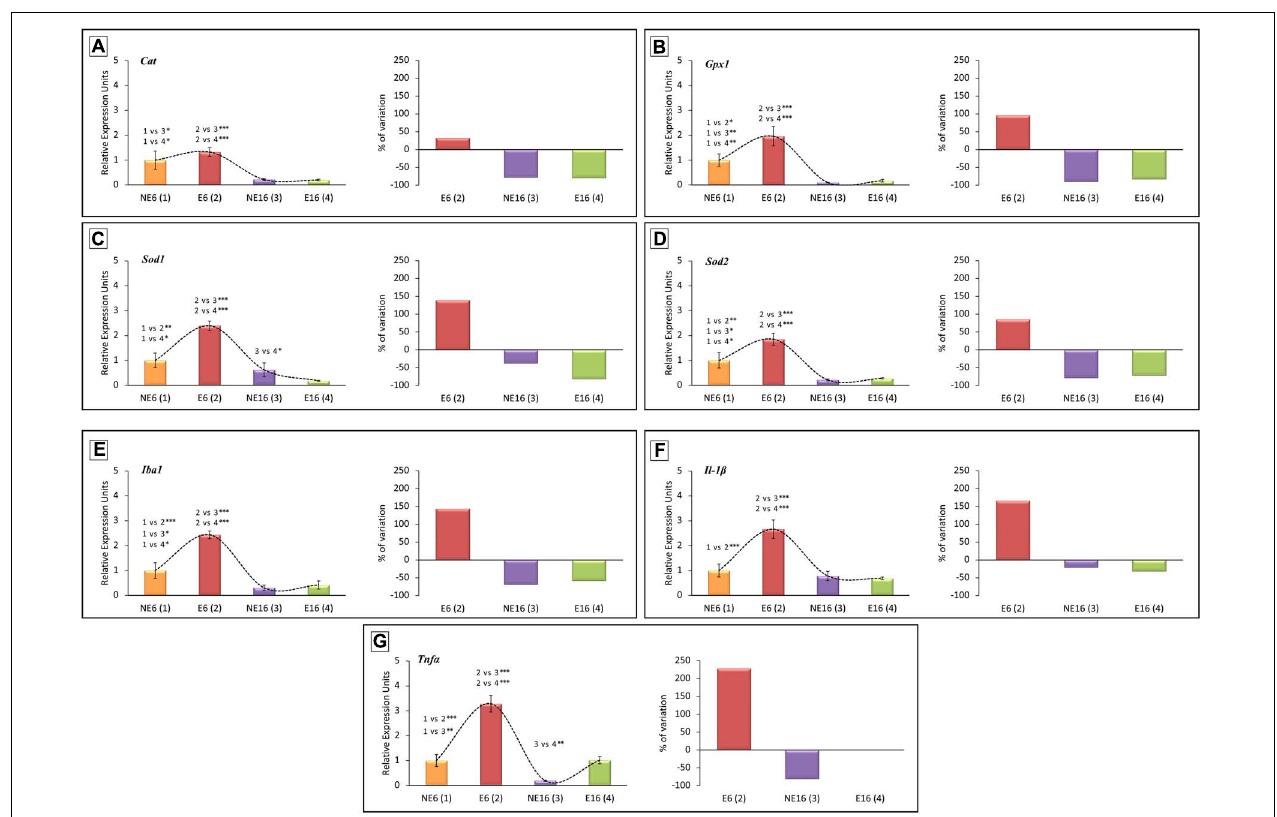
FIGURE 7 | Quantitative PCR expression profiles of genes related to antioxidant capacity (A–D) and inflammation (E–G) in the cochlea of young/adult and aging rats exposed to NAP. In rats exposed to NAP (E6), the relative expression of Gpx1 (B) , Sod1 (C) , and Sod2 (D) were significantly higher than NE6 baseline levels and NE16 and E16 rats (see section “Results”). However, Cat (A) , Gpx1 (B) , and Sod2 (D) transcription levels in the cochleae of older unexposed rats (NE16) were significantly lower than in NE6 and E6 rats. Similarly, the expression of all antioxidant genes evaluated in the cochleae of E16 rats decreased relative to the NE and E6 groups. (A–D) The expression of the inflammation-related genes Iba1 (E) , Il-1 β (F) , and TNF α (G) increased significantly in E6 rats relative to unexposed control baseline and aging rats. As aging progressed, expression of Iba1 (E) and TNF α (G) genes in NE16 and E16 cochleae decreased significantly. ∗ p < 0.05; ∗∗ p < 0.01; ∗∗∗ p < 0.001. Data presented as mean ± SEM of triplicate samples ( n = 4 for each animal group). n = 4 for each animal